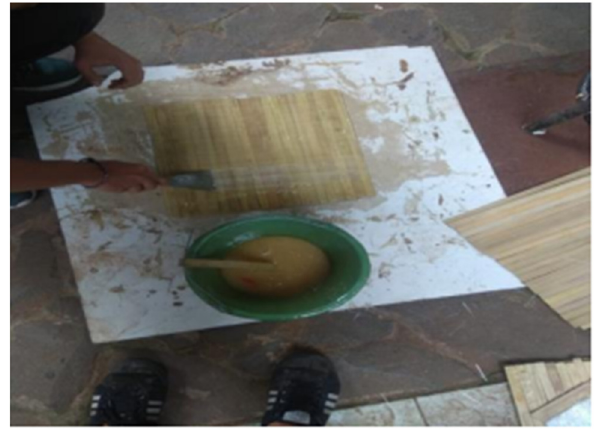
Figure 3: Apus bamboo gluing process.